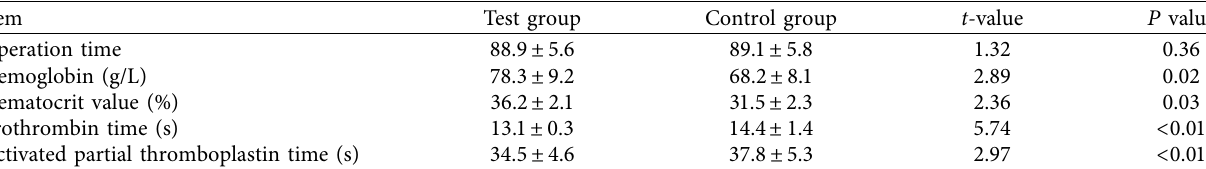
Table 2: The operation time and postoperative observation indexes after operation between the two groups.